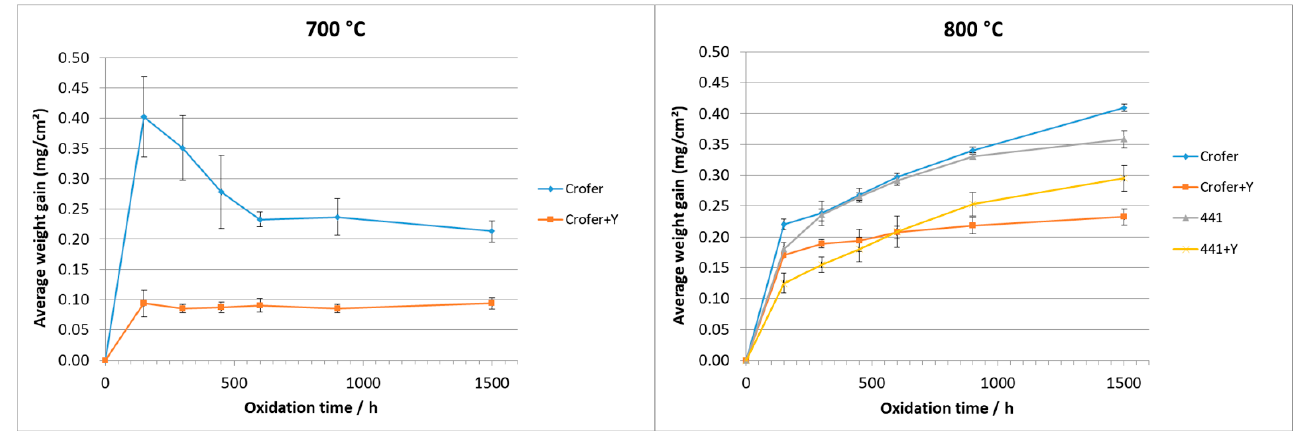
Figure 3. Average weight gain of the samples in reducing atmosphere at 700 °C and 800 °C with standard deviations.